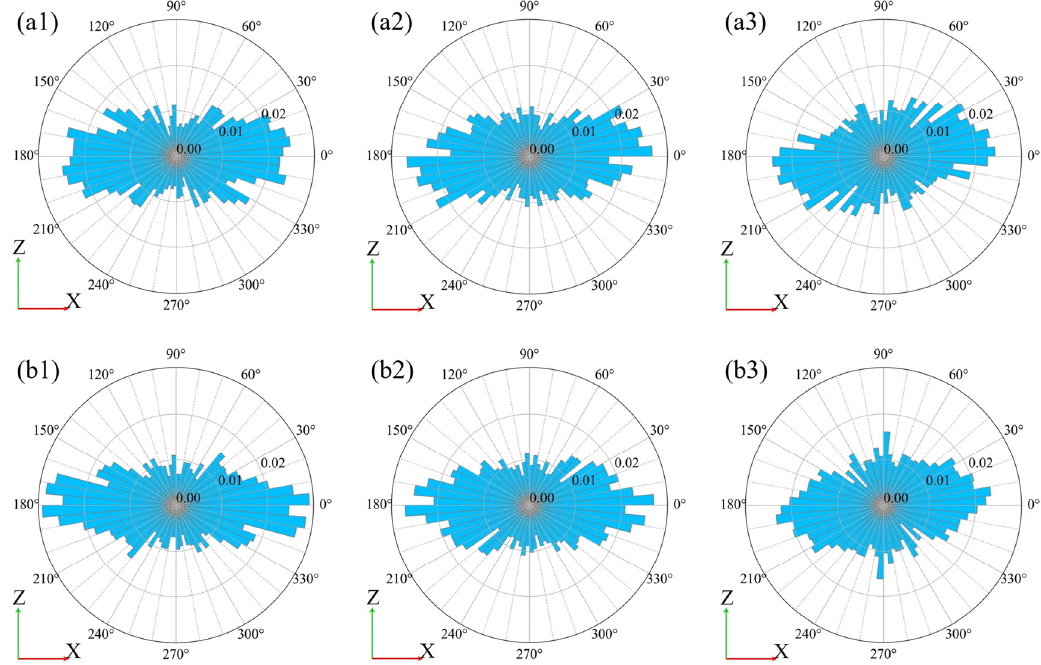
Figure 16. Histograms of particle direction of the long axis on the vertical plane (XZ plane): ( a1 – a3 ) are G5; ( b1 – b3 ) are G4. The left columns represent S0 (initial state), the center columns S2 (D h = 3 mm), and the right columns S4 (D h = 8 mm). D h , horizontal displacement.